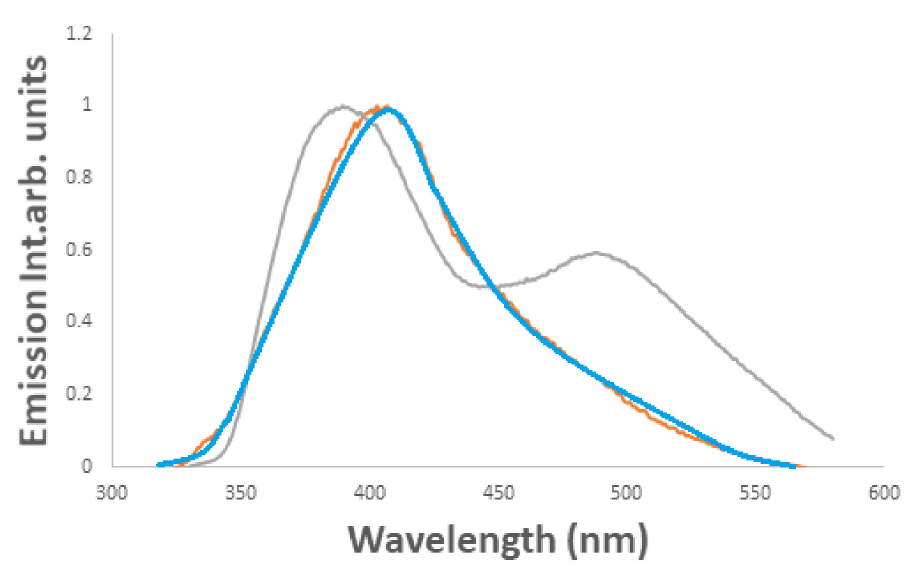
Figure 20. Normalized fluorescence spectra of 2-amino-4-hydroxy-6-(4-hydroxy-2-oxo-2H-chromen- 3-yl)nicotinonitrile 4 6.8 × 10 − 5 M in CH 3 CN λ ex = 304 nm, fresh λ em, max 406 nm, alkalized usingNaOH λ em, max 404 nm, and acidified using H 2 SO 4 λ em, max 387 nm.